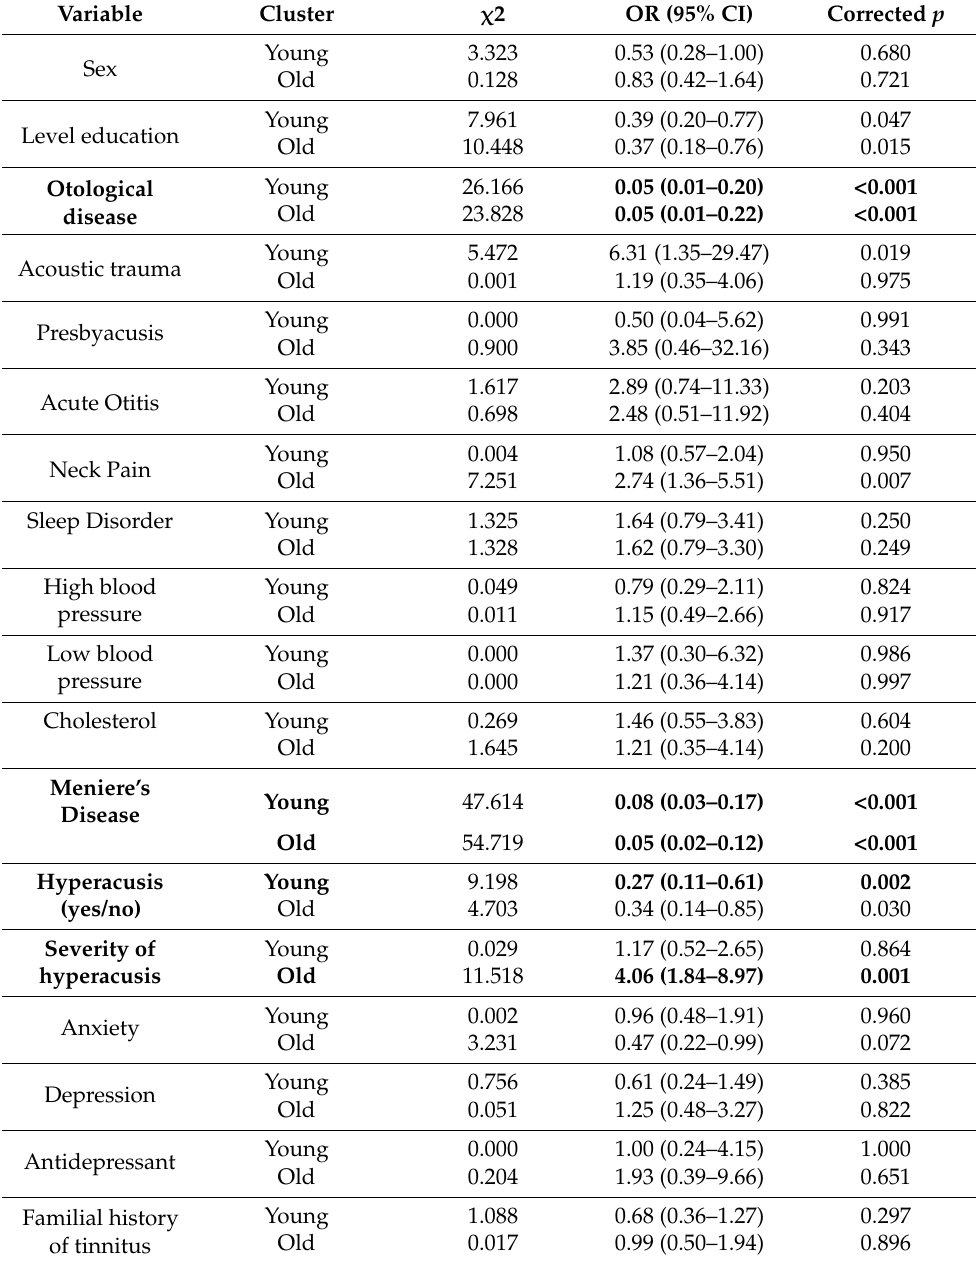
Table 5. Comparison of the main clinical variables in the ESIT-SQ according to the age of patients with chronic